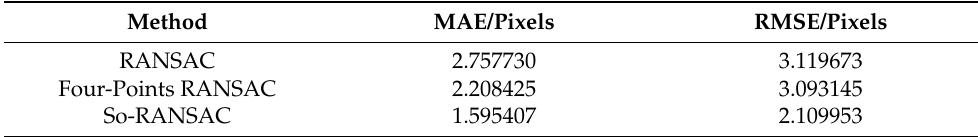
Table 5. Comparison of the reprojection